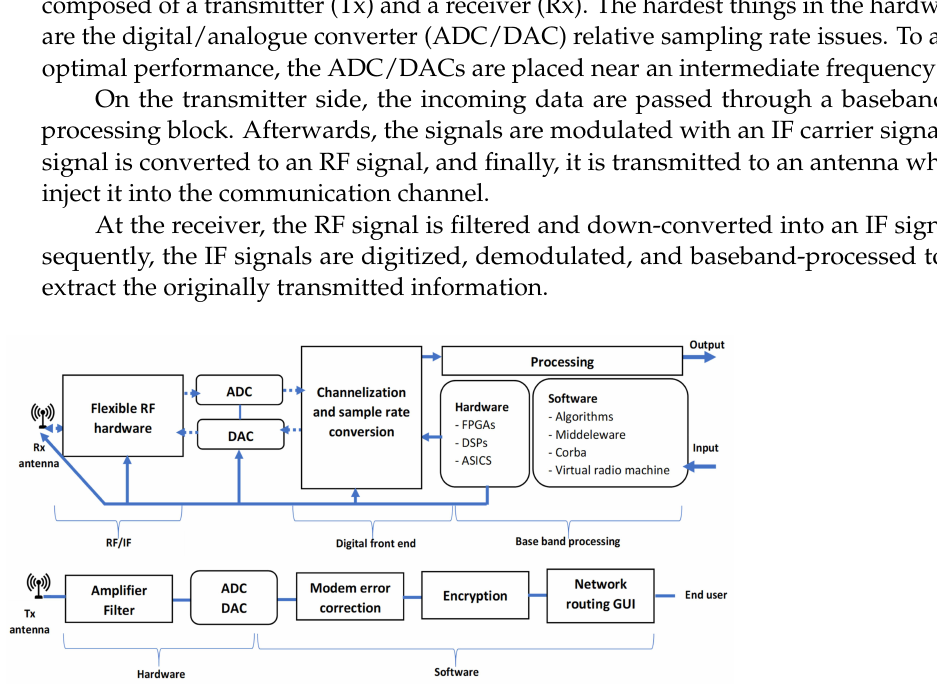
Figure 3. SDR architecture concept: the scheme clearly demonstrates the hardware and software parts that are fused